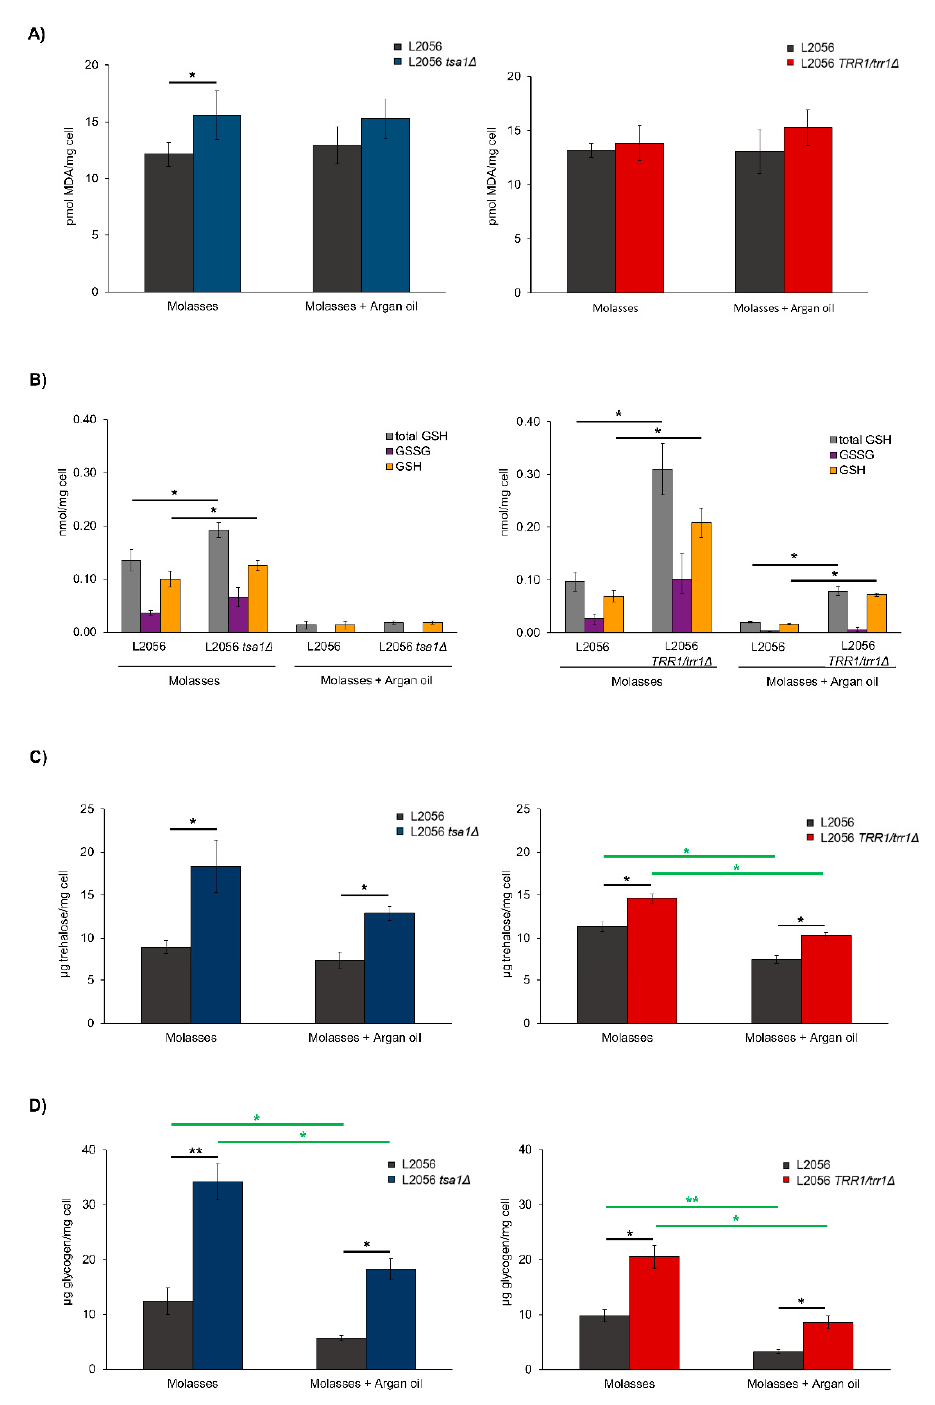
Figure 3. Oxidative stress parameters during growth in molasses. L2056, the L2056 tsa1 ∆ mutant and L2056 trr1 ∆ / TRR1 were grown for 24 h in flasks with molasses, with and without argan oil 12 µ L / mL. ( A ) Lipid peroxidation. ( B ) Total, reduced and oxidized glutathione. ( C ) Accumulated trehalose. ( D ) Accumulated glycogen. Experiments were carried out in triplicate. The mean and standard deviation are shown (* p < 0.05; ** p < 0.01, Student’s t test).